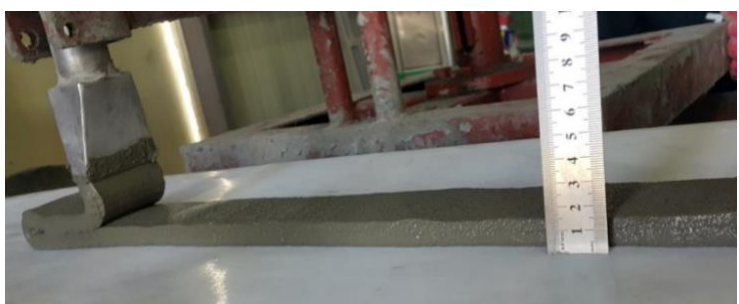
Figure 1. View of additive construction by extrusion test.